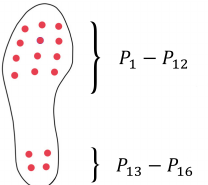
Figure 2. The sensor layout of the